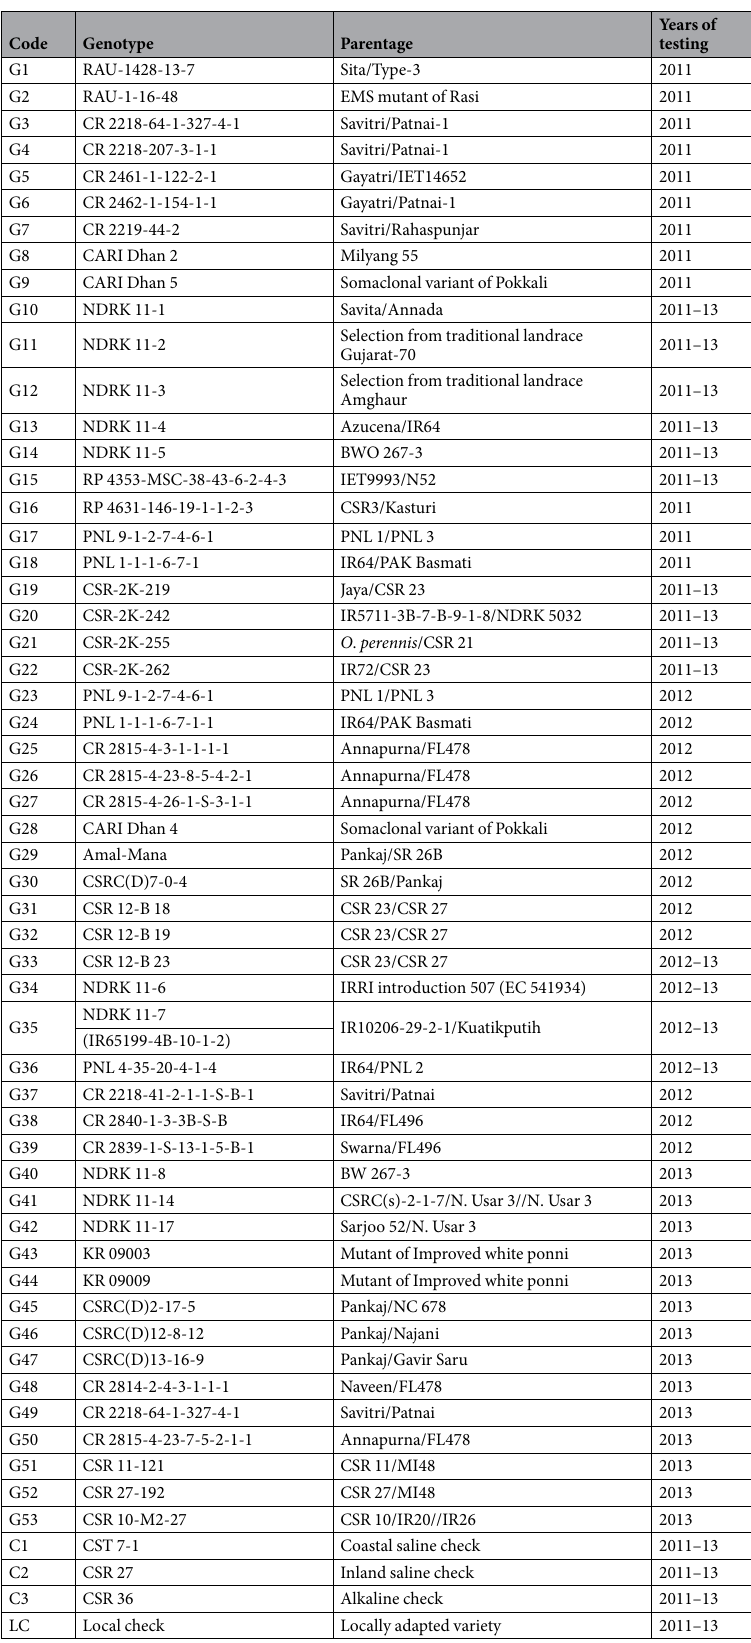
Table 6. Details of rice genotypes used in the